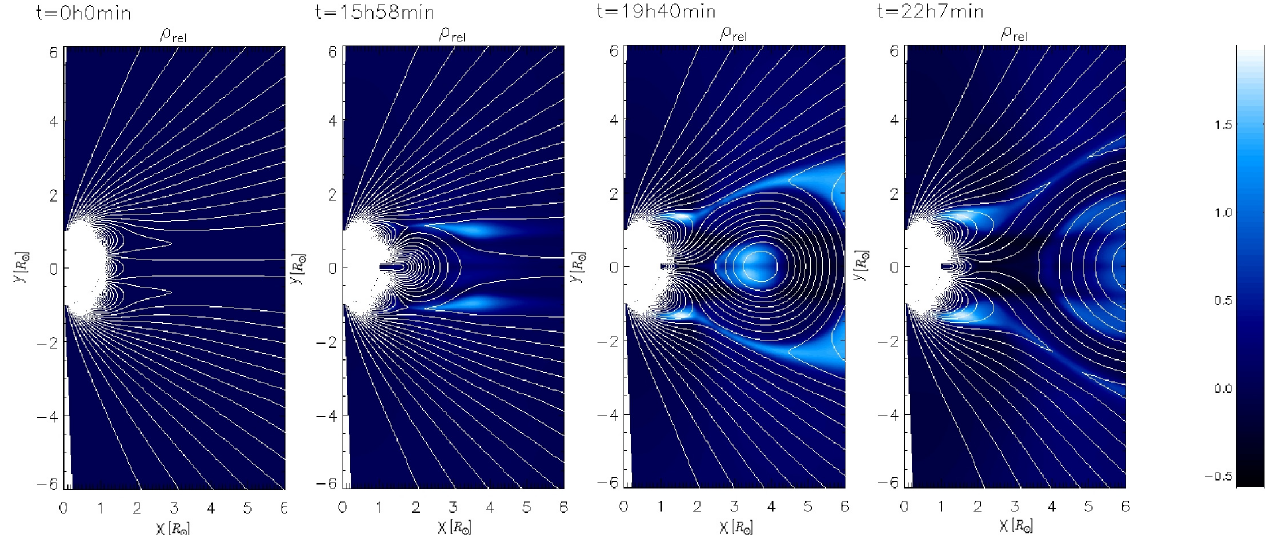
Fig. 4. Snapshots showing the relative mass density and magnetic field lines at different times during our simulation. The left panel shows the initial configuration. The second panel shows how the relative density has evolved after t =15h 58min. The third panel shows how the relative density has evolved after t =19h 40min and clearly shows how the expanding CME is pinching the northern and southern streamers. The fourth panel shows the evolution after t =22h 7min when we can clearly see how induced lateral reconnection has detached the top parts of the two streamers.